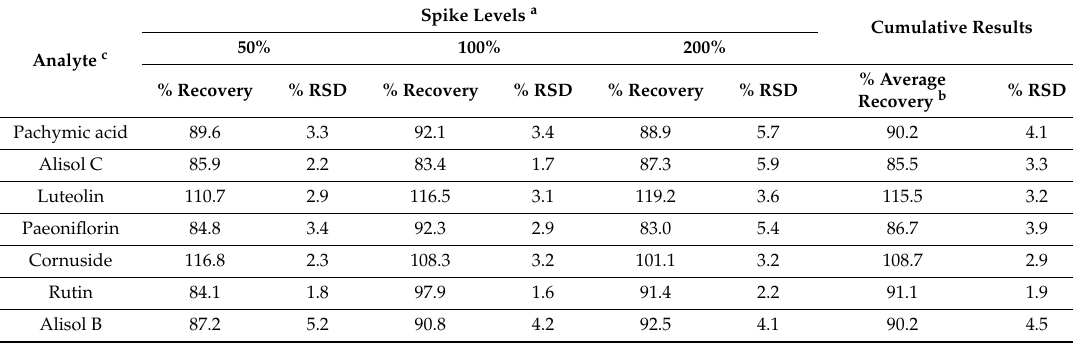
Figure 1. The representative MS chromatographic spectra of sample A-III containing (1) Rutin, (2) Cornuside, (3) Paeoniflorin, (4) Luteolin, (5) Alisol C, (6) Pachymic acid, and (7) Alisol B. Table 6. The analyte recoveries.